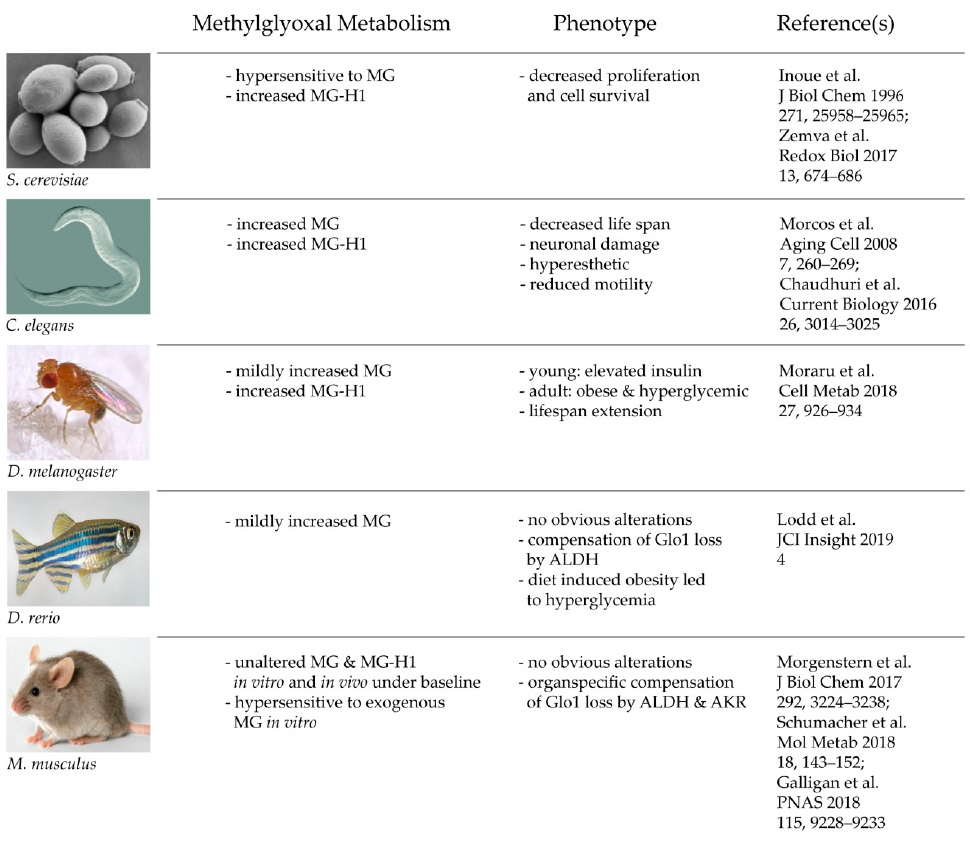
Figure 2. Consequences of a total loss of glyoxalase 1 in various model organisms.